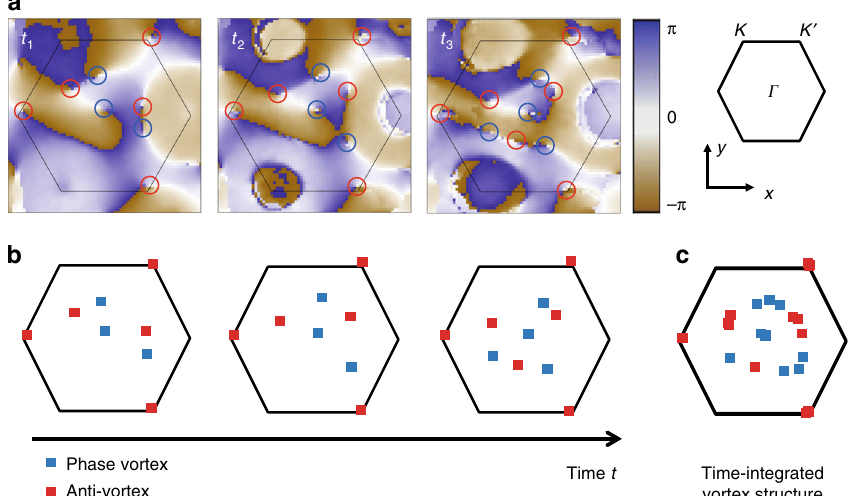
Fig. 6 Extracting the vorticity of the phase pro fi les. a Azimuthal phase pro fi le ϕ ( k ) of the time-evolved state with the identi fi ed vortices marked by red and blue circles as a guide to the eye. b Vorticity of the phase pro fi les with the position of the vortices and anti-vortices marked by blue and red squares, respectively. While the phase pro fi le itself is distorted for state tomography in dispersive bands, the vortices can be clearly identi fi ed and their interpretation is not compromised. c The time-integrated vorticity clearly shows the static vortices at the Γ and K ′ points and the closed contour of dynamical vortices. The detuning is δ = − 2 π ⋅ 372 Hz; the evolution times are t 1 = 0.507ms, t 2 = 0.663 ms and t 3 = 0.819